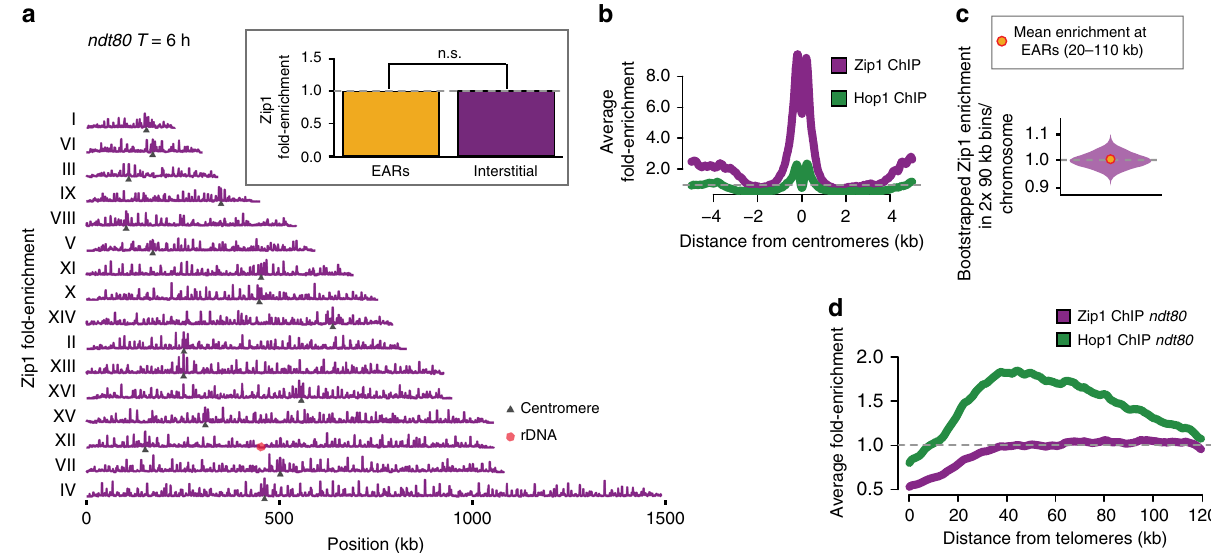
Fig. 3 Zip1 is not depleted from EARs. a Zip1 ChIP-seq enrichment (magenta) in ndt80 Δ -arrested late prophase cells plotted along each of the 16 yeast chromosomes; black triangles mark the centromeres and the red hexagon marks the rDNA locus. The data are normalized to a global mean of 1. Inset shows mean enrichment in EARs (20 – 110 kb, orange) and interstitial chromosomal regions (magenta) in extended prophase ( T = 6 h). P = 0.564 (n.s.), Mann-Whitney-Wilcoxon test. b Zip1 (magenta) and Hop1 (dark green) ChIP-seq enrichment around centromeres from ndt80 Δ -arrested cultures in late prophase ( T = 6 h). c Bootstrap-derived distributions within two 90-kb bins per chromosome from Zip1 ChIP-seq data are depicted as a violin plot. The horizontal lines in the violin plot represent the median and the two-ended 95% CIs. The mean Zip1 ChIP-seq enrichment in EARs (20 – 110 kb) is shown as orange/red dots. d Hop1 (dark green) and Zip1 (magenta) ChIP-seq enrichment in late prophase ( T = 6 h) is plotted as a mean enrichment in the EARs (32 domains) as a function of the distance from telomeres. The gray dashed line is genome